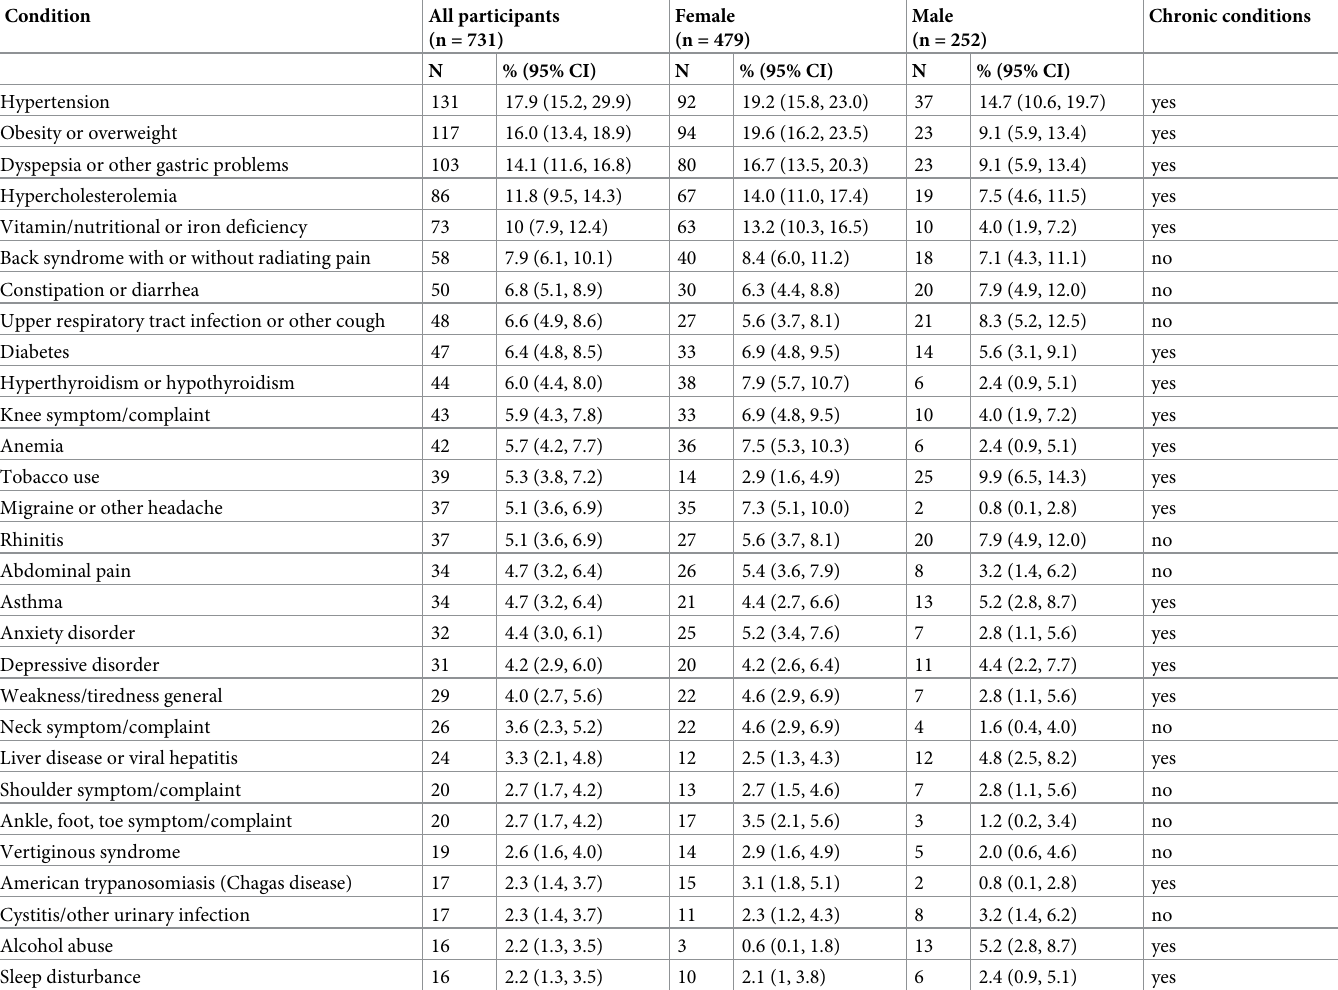
Table 2. Prevalence and characteristics of the most frequent health problems encountered in male and female undocumented